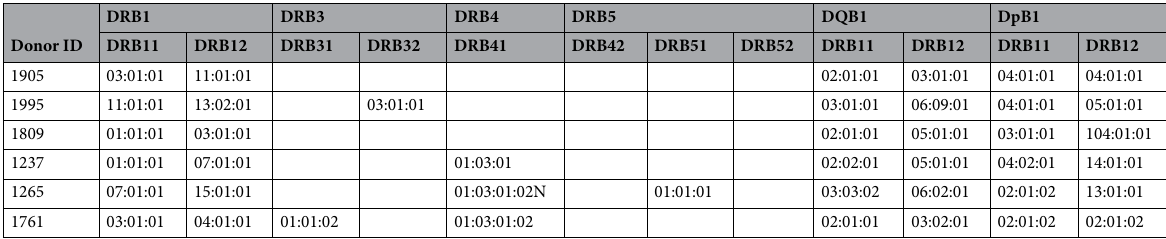
Table 2. HLA haplotype per donor based on genotype.